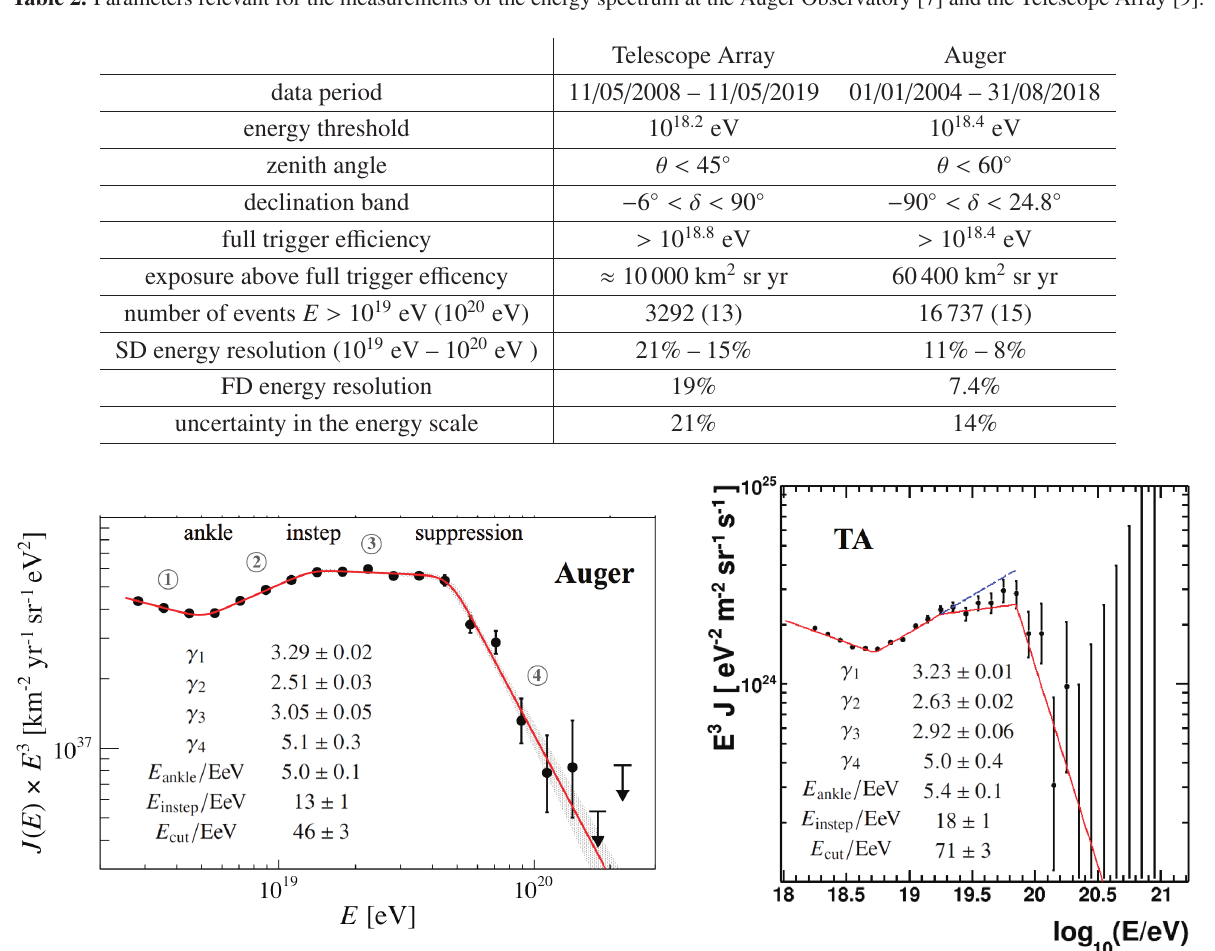
Figure 1. Energy spectrum and spectral features measured by Auger [7] and TA [9]. Only statistical uncertainties are shown. For a rough estimation of the systematic uncertainties in the energy that defines the transition points one can consider the total uncertainty in the energy scale reported in table 1 with the remark that it would be fully correlated for the di ff erent inflection points.